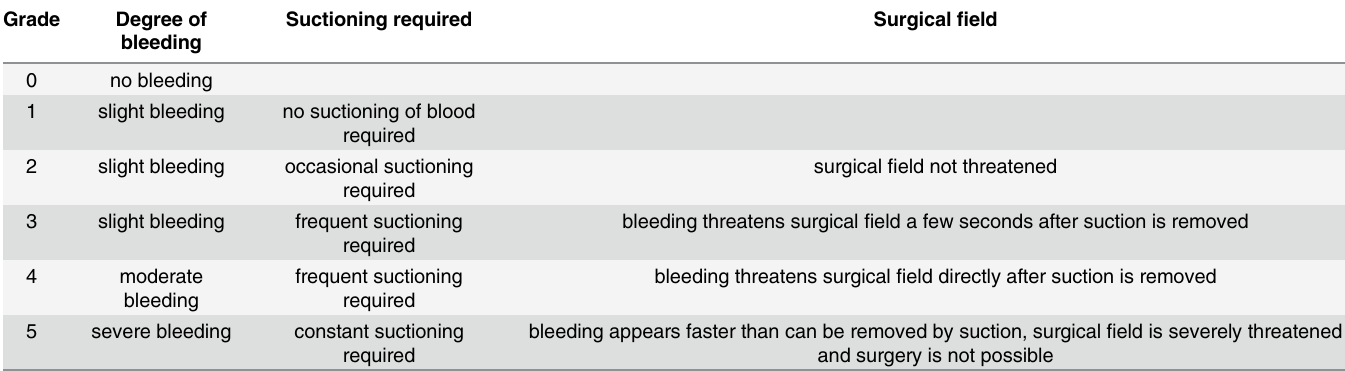
Table 1. Criteria for intraoperative bleeding.